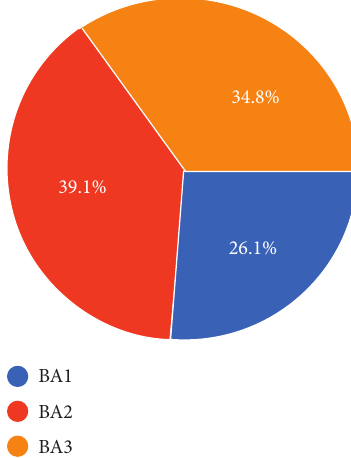
Figure 4: Academic levels of the participants.